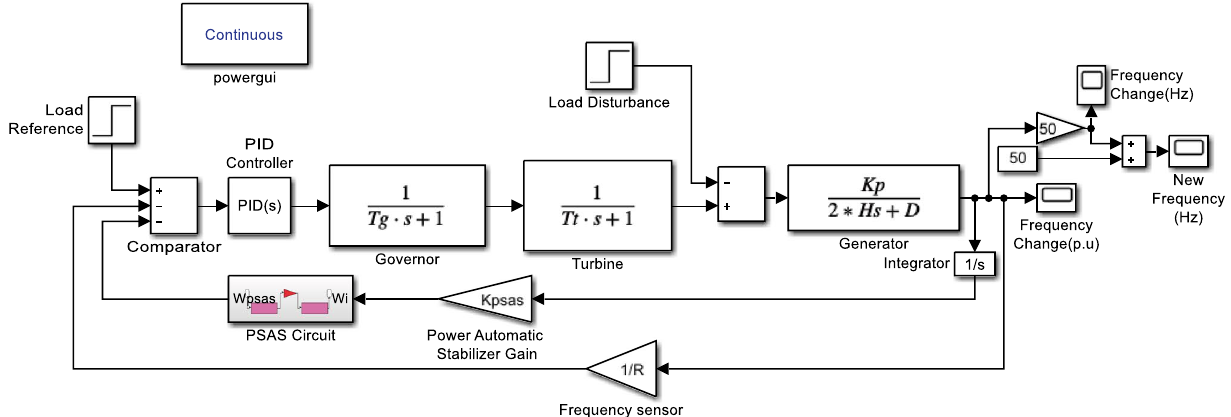
Fig. 8 Proposed Single area generation PID-PSAS control Technique